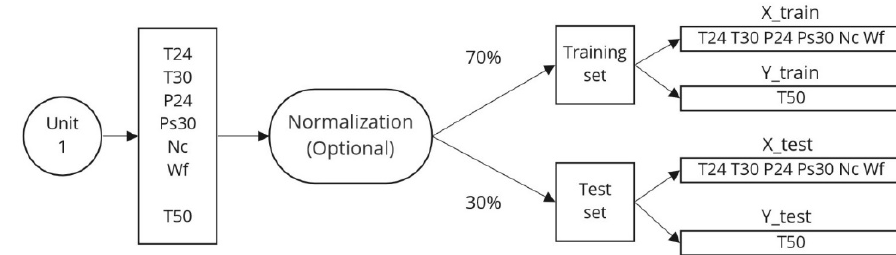
Figure 5. Data preprocessing.